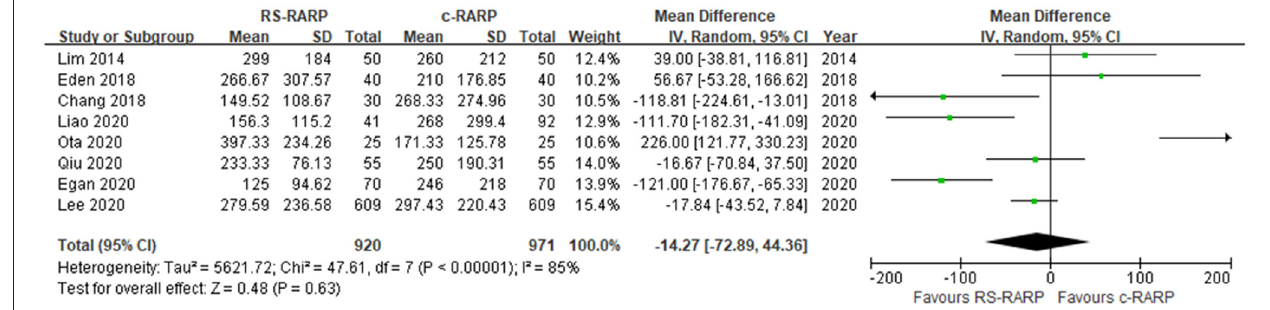
FIGURE 3 | Forest plot of estimated blood loss.